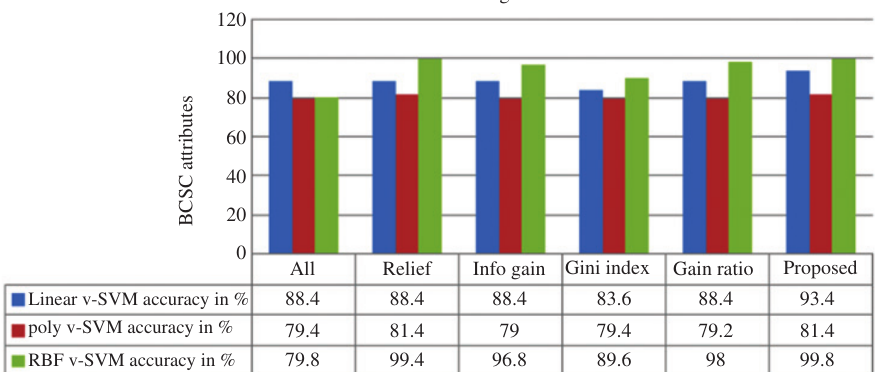
Figure 2: Validating the Performance of BCSC Feature